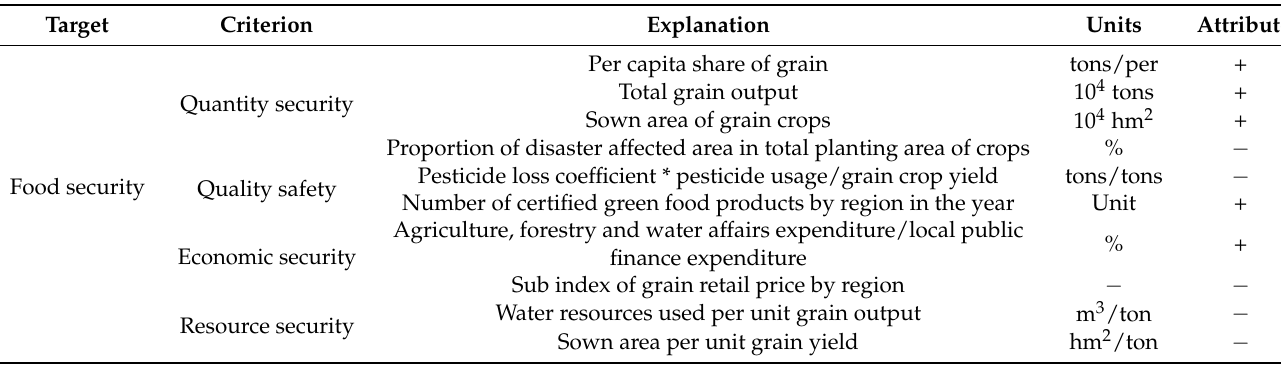
Table 4. Index system for measuring food